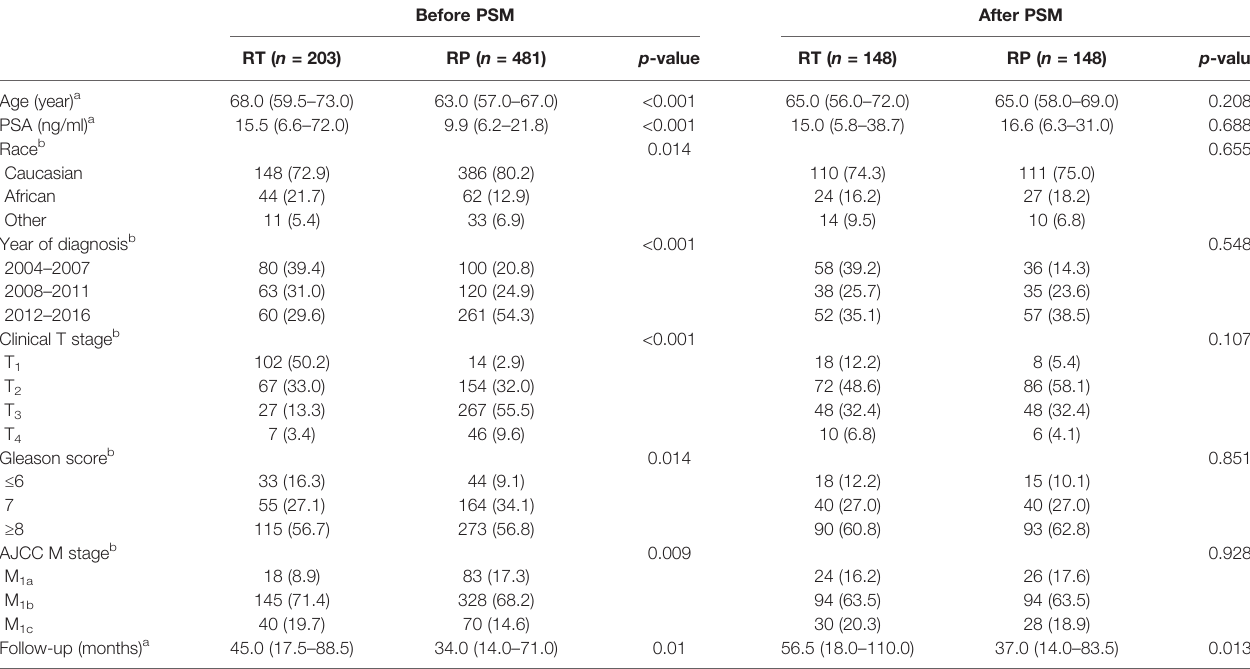
PSM, propensity score matching; RP, radical prostatectomy with or without external beam radiation therapy; RT, brachytherapy with or without external beam radiation therapy; PSA, prostate-speci fi c antigen. a Data are presented as median (interquartile range). b Data are presented as n